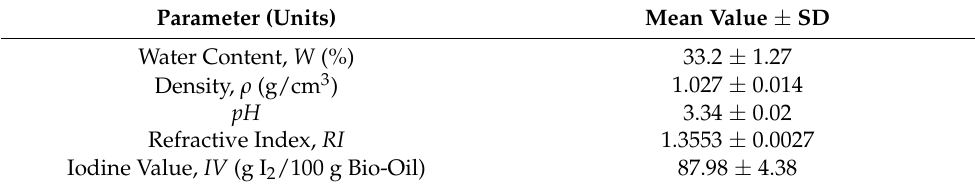
Figure 10. Pyrolysis liquid (bio-oil). Table 3. Physicochemical properties of